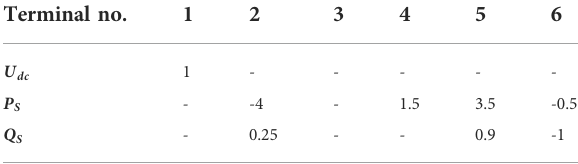
TABLE 5 Desired DC grid power fl ow pattern (in P.U.).